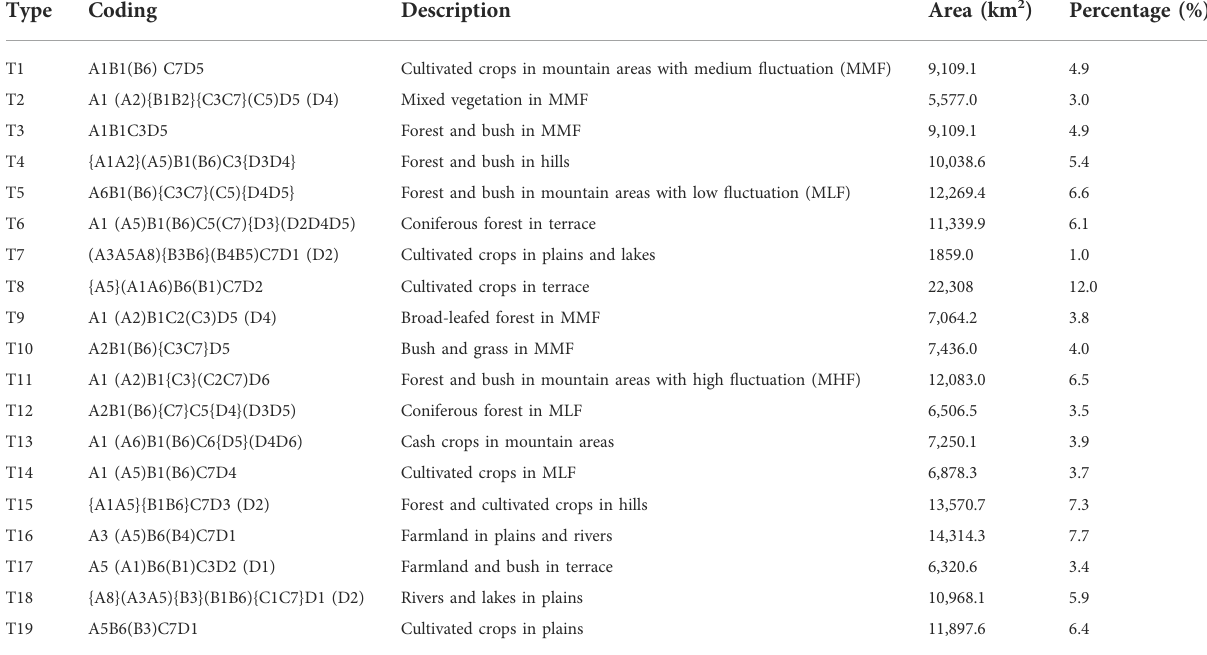
TABLE 2 Coding and description of different landscape character types and their proportions in area.